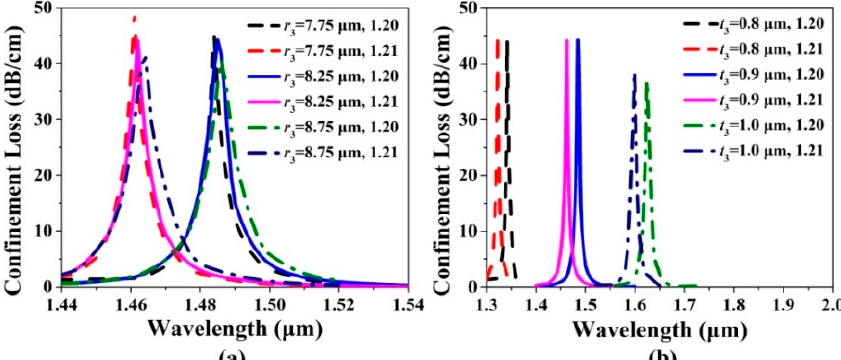
Figure 5. The confinement loss spectra of the x -pol core mode when ( a ) r 3 increases from 7.75 to 8.75 µ m and ( b ) t 3 increases from 0.8 to 1.0 µ m for the RIs of the filled analyte of 1.20 and 1.21, respectively.